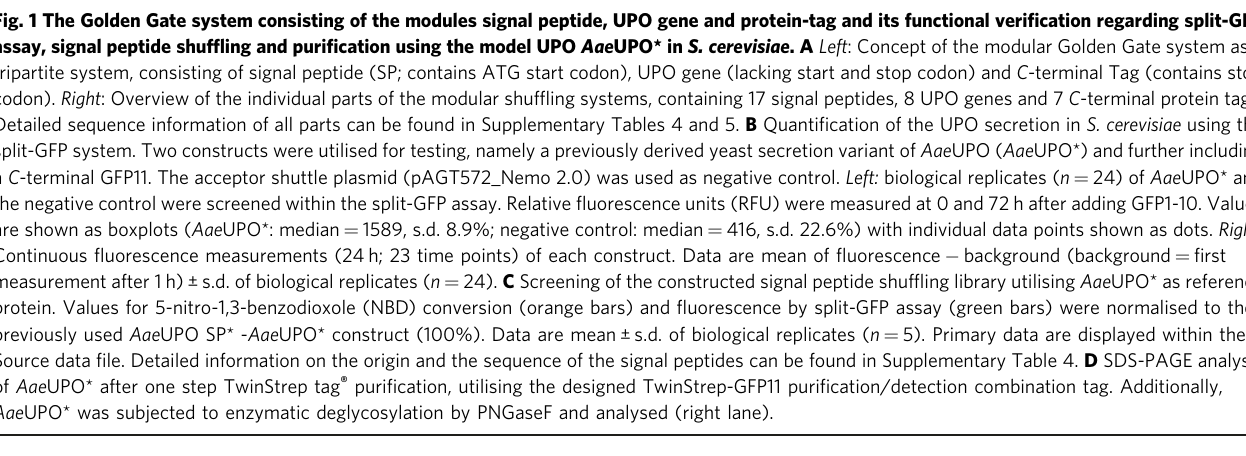
Fig. 1 The Golden Gate system consisting of the modules signal peptide, UPO gene and protein-tag and its functional veri fi cation regarding split-GFP assay, signal peptide shuf fl ing and puri fi cation using the model UPO Aae UPO* in S. cerevisiae . A Left : Concept of the modular Golden Gate system as a tripartite system, consisting of signal peptide (SP; contains ATG start codon), UPO gene (lacking start and stop codon) and C -terminal Tag (contains stop codon). Right : Overview of the individual parts of the modular shuf fl ing systems, containing 17 signal peptides, 8 UPO genes and 7 C -terminal protein tags. Detailed sequence information of all parts can be found in Supplementary Tables 4 and 5. B Quanti fi cation of the UPO secretion in S. cerevisiae using the split-GFP system. Two constructs were utilised for testing, namely a previously derived yeast secretion variant of Aae UPO ( Aae UPO*) and further including a C -terminal GFP11. The acceptor shuttle plasmid (pAGT572_Nemo 2.0) was used as negative control. Left: biological replicates ( n = 24) of Aae UPO* and the negative control were screened within the split-GFP assay. Relative fl uorescence units (RFU) were measured at 0 and 72 h after adding GFP1-10. Values are shown as boxplots ( Aae UPO*: median = 1589, s.d. 8.9%; negative control: median = 416, s.d. 22.6%) with individual data points shown as dots.